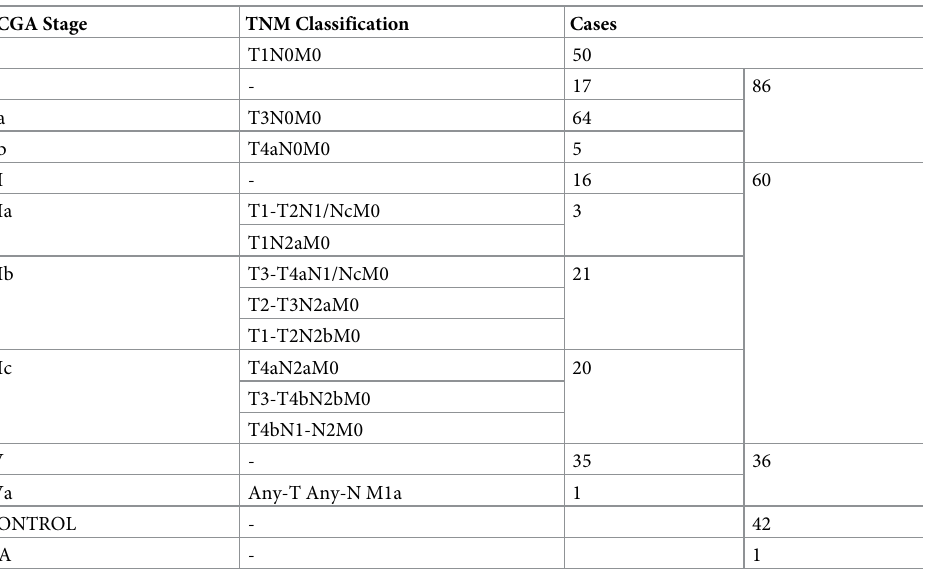
Table 1. AJCC cancer